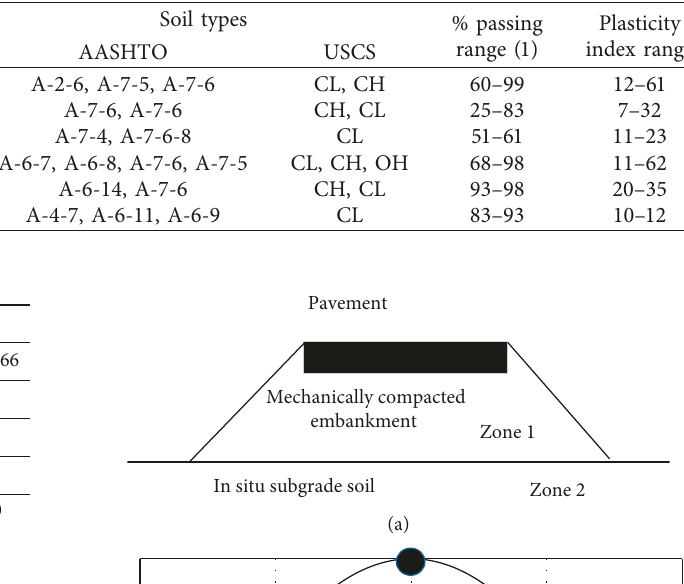
Table 2: Project locations and soil information.